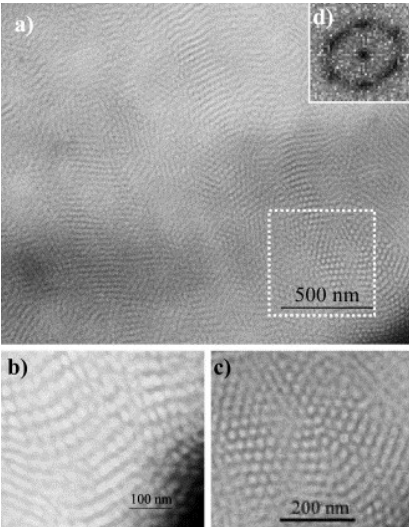
Figure 2. Transmission electron microscopy (TEM) of RuO ( T = − 80 °C) thin sections of p(MA-POSS) nanocomposites: ( a ) overall morphology; ( b , c ) cylindrical morphology; and ( d ) Fourier transform of the area are enclosed in dotted lines. Reproduced with permission from Pyun et al. [51], Copyright 2003,